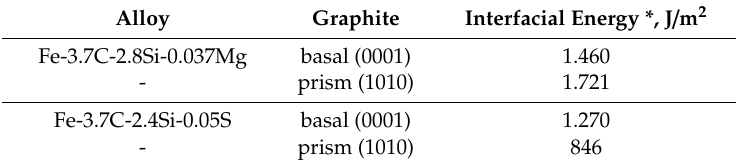
Table 1. Melt / graphite interfacial energy in Fe-C-Si alloys at 1200 ◦ C in the absence of oxygen [53]. Alloy